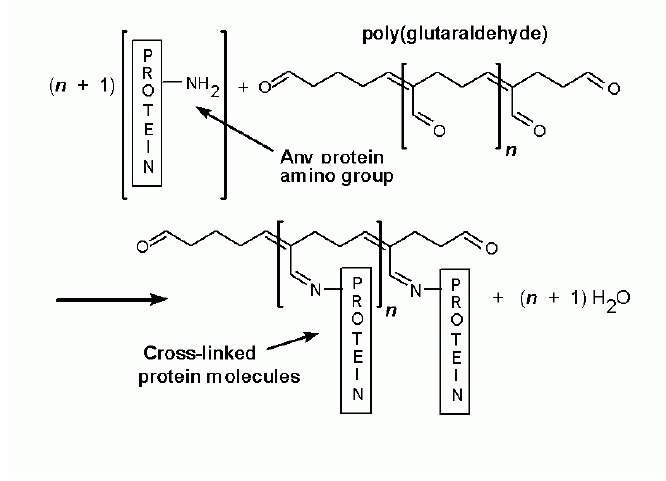
Figure 2. Cross-link reaction between glutaraldehyde and